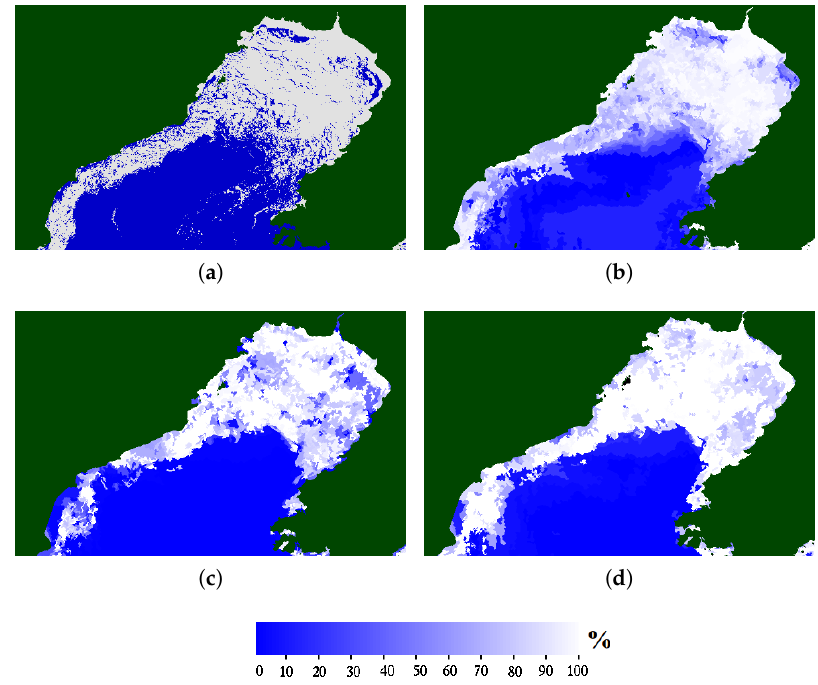
Figure 14. ( a ) HuanJing-1B (HJ-1B)-based pixel-wise classification into ice and water by thresholding; ( b ) HJ-1B based ice concentration computed for the SAR segments; ( c ) SAR ice concentration estimate computed using the linear approach; and ( d ) the MLP approach. Cloud contaminated HJ-1B areas were